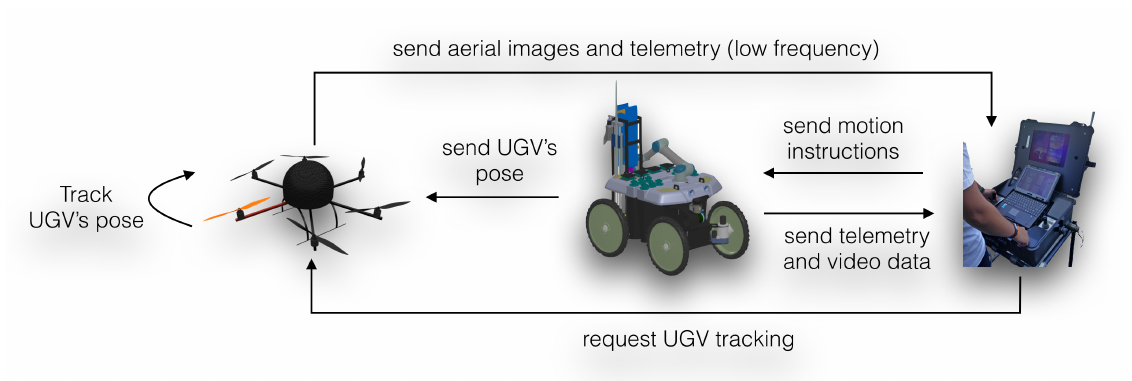
Figure 16. Mission execution interaction